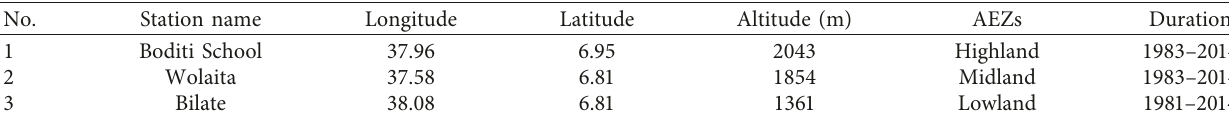
Table 2: Selected meteorological station in Wolaita